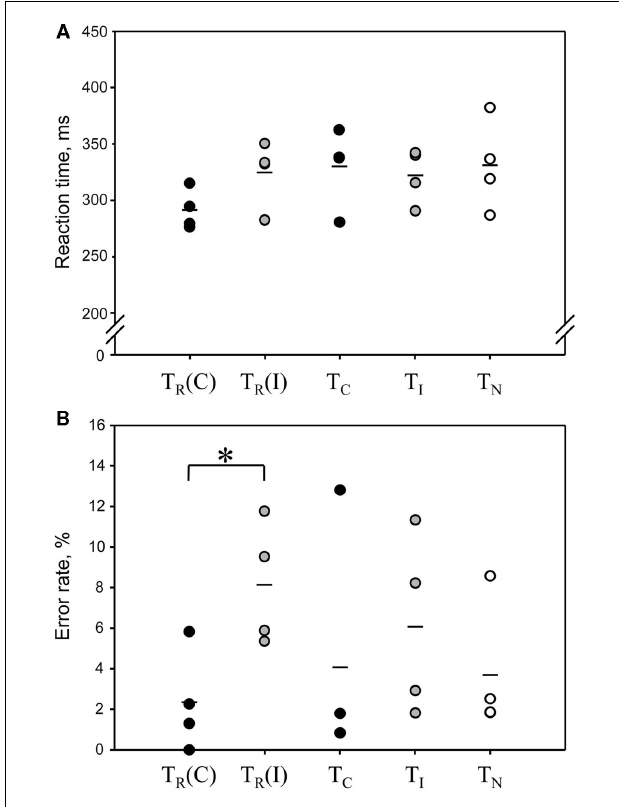
FIGURE 4 | Reaction times (A) and error rates (B) in the Simon tasks combined with PET imaging. Each dot represents the result from one animal ( n = 4). Mean values are indicated by a short line. In the classical Simon task T R , where compatible and incompatible trials were presented in randomized order, the results for compatible and incompatible trials were analyzed separately [ T R (C) and T R (I)].There was a significant Simon effect on error rate, but not on reaction times. T R (C) and T R (I) correspond to black and gray bars, respectively, of the condition “50% incompatible trials” in Figure 2 . Control tasks: T C , compatible trials only; T I , incompatible trials only; T N , neutral trials only.